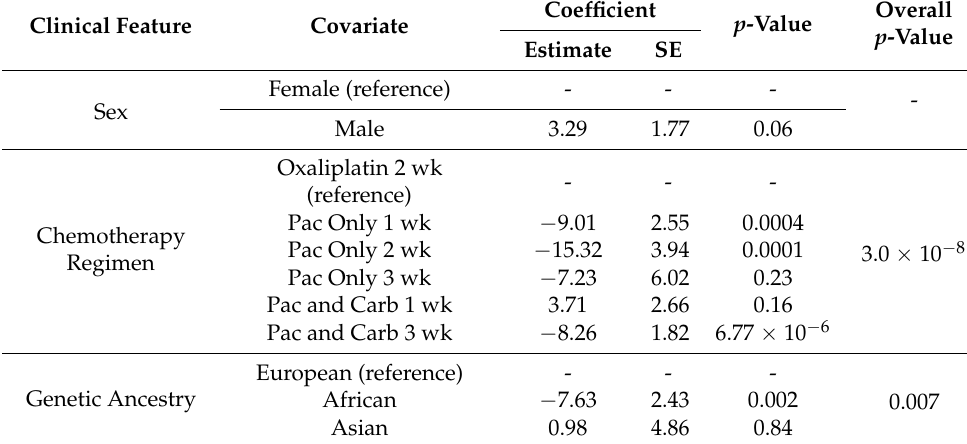
Table 2. Multivariate linear regression